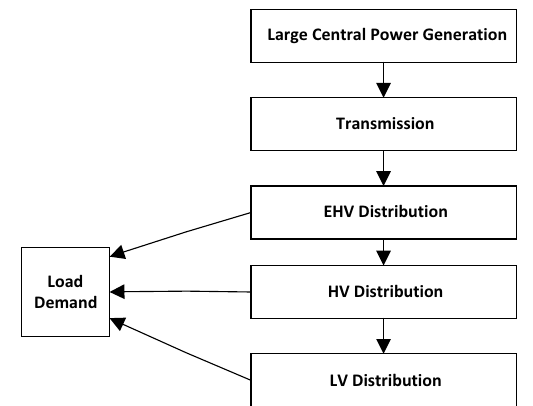
Fig. 1 Conventional energy delivery